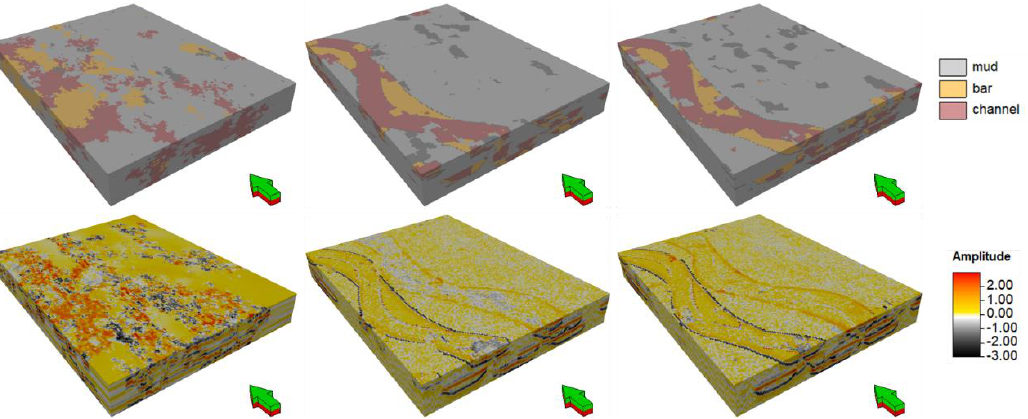
Figure 4. Lithofacies and forward modeling records of the inversion ( left ) TPI, ( middle ) MPI, and ( right ) LPUMI.